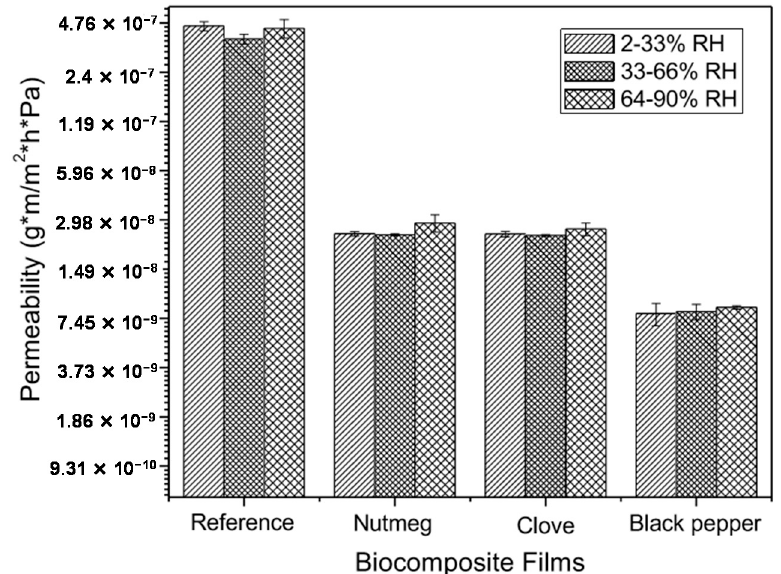
Figure 4. Water vapor permeability of biocomposite films containing oleoresins and reference (without oleoresin). Different letters in the same column indicate significant differences ( p < 0.05).